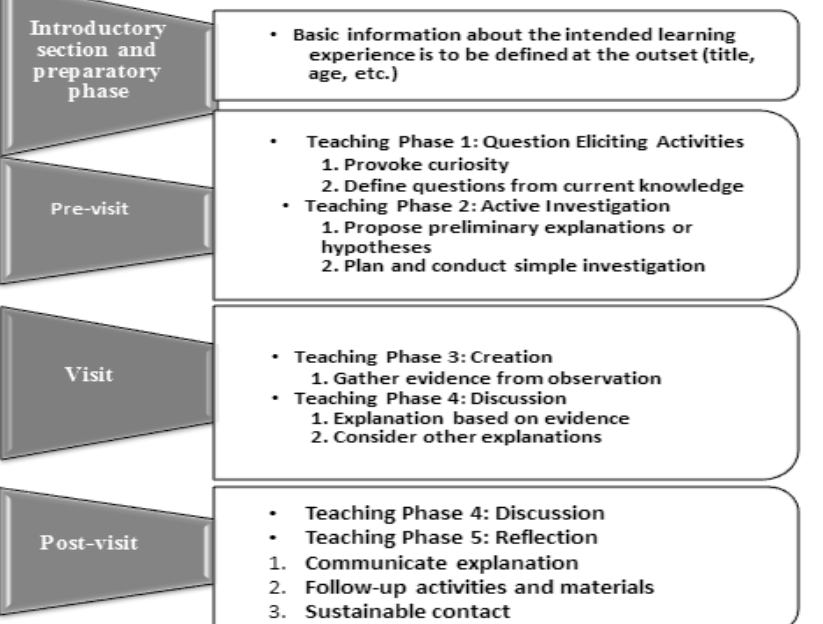
Figure 3: The educational pathway structure for students Source: Kavouras, M. (2013). Semantic pathways for building a spatially-thinking society. Athens: Pro- ject